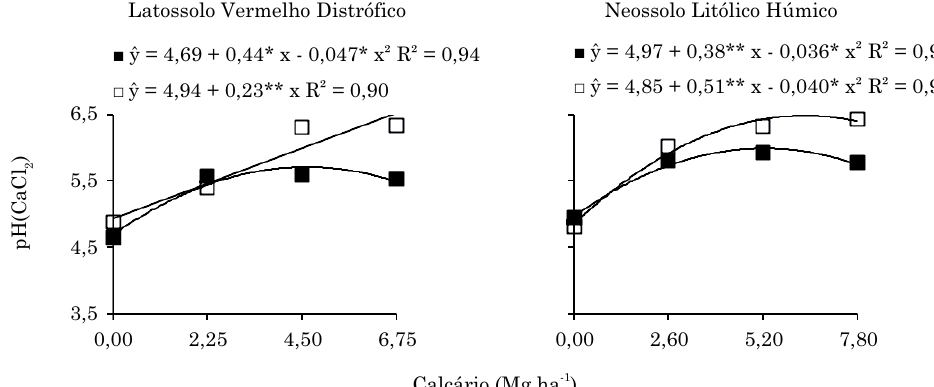
Figura 3. Alterações no pH em CaCl 2 da camada superficial (0,00-0,05 m) do Latossolo Vermelho Distrófico e do Neossolo Litólico Húmico, de acordo com as doses de calcário dolomítico (■) e calcítico (□) aplicadas na superfície em sistema plantio direto. os valores são médias de duas faixas de prnt (B e d) dos corretivos. A calagem foi realizada em agosto de 2010, e as amostras de solo foram coletadas em agosto de 2011. * e **: significativo a 5 e 1 %,